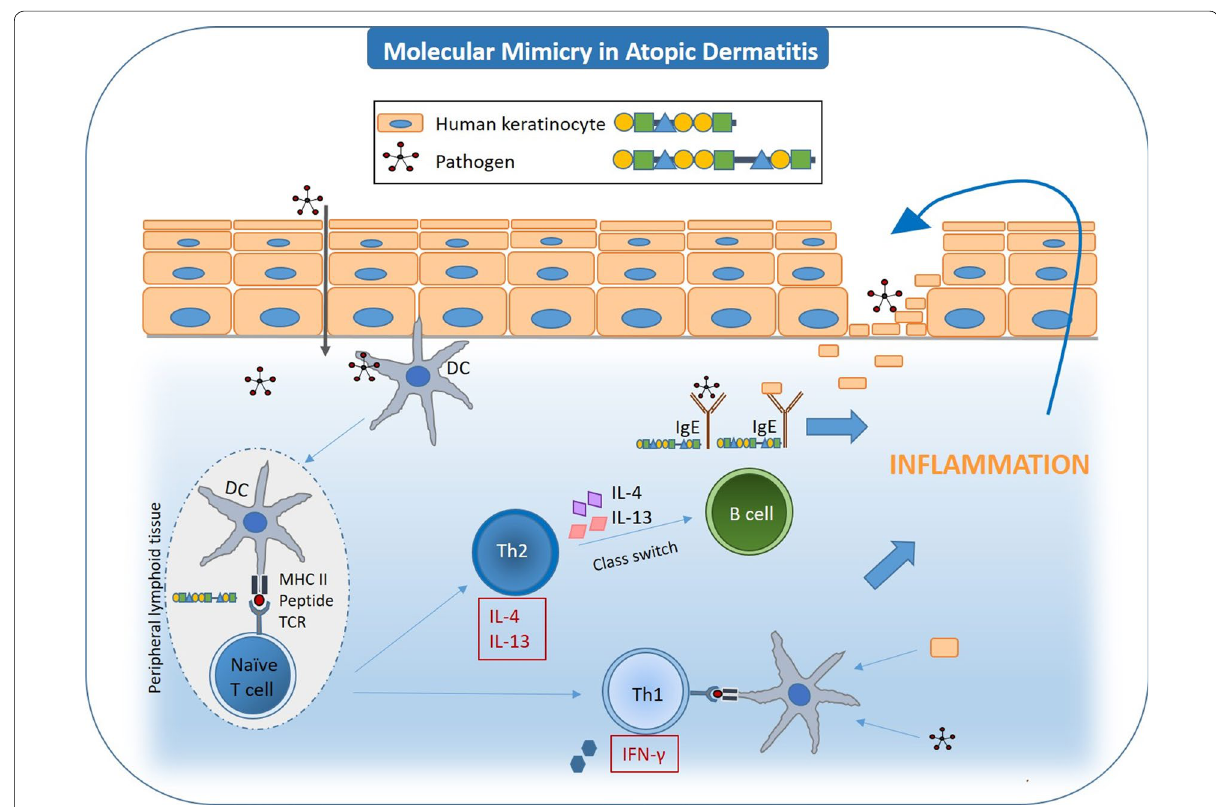
Fig. 2 Molecular mimicry can lead to IgE antibody production against self‑antigens. An impaired barrier function facilitates access to environmental allergens and pathogens resulting in allergic sensitization and specific IgE antibody production. In the case of structural homologies of the epitopes (molecular mimicry), this can result in cross reactivity between exogenous antigens and self‑antigens. DC dendritic cell, Th2 T helper 2 lymphocytes, IgE immunoglobulin E, IL-4